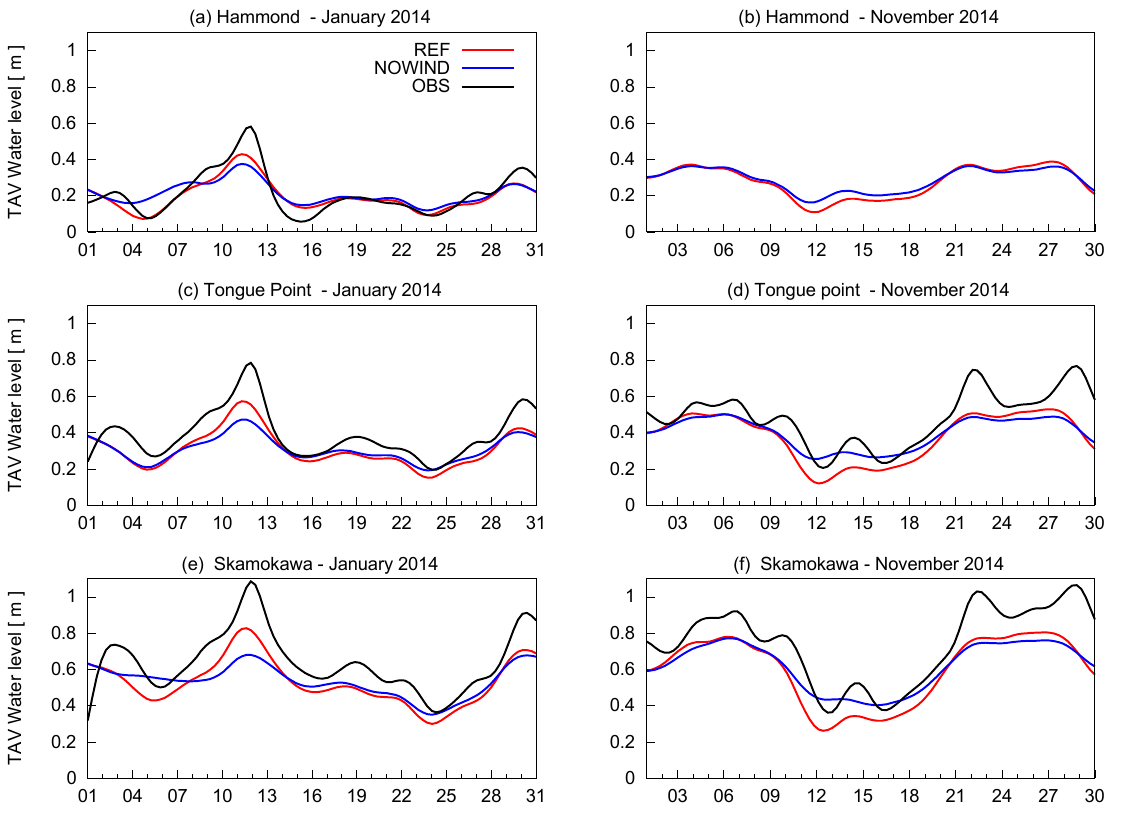
Figure 5. Time series of water level (after removing tides) at the three available tide gauges. Data at Hammond were not available in November 2014. The red and blue lines refer to the REF and NOWIND simulations, respectively. The black line refers to the observations.